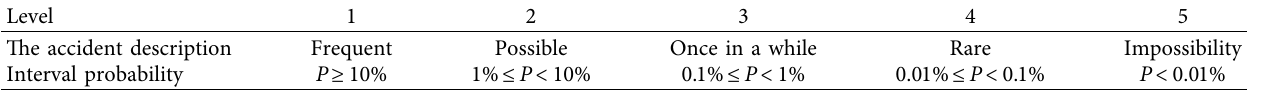
Table 2: Criteria for the probability grade of risk occurrence.